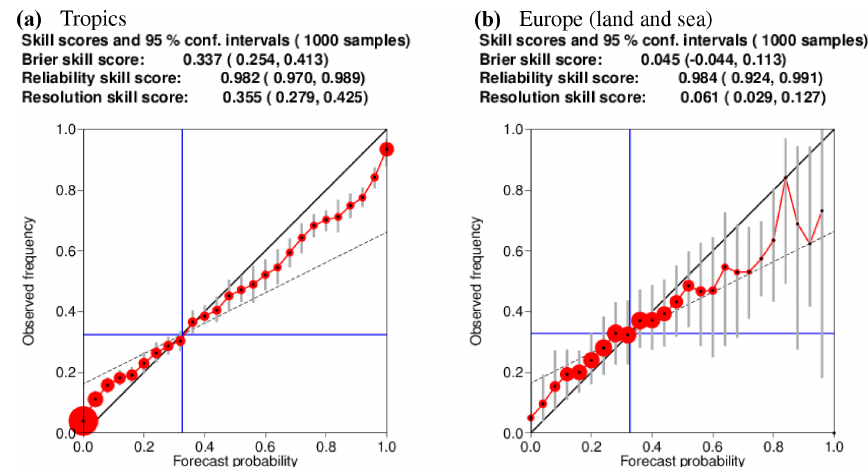
Figure 23. DJF 2m temperature reliability diagrams for SEAS5, computed including all grid points for the tropics ( a , 20 ◦ N to 20 ◦ S) and a European region ( b , 35 to 75 ◦ N, 12.5 ◦ W to 42.5 ◦ E) over the whole re-forecast period using 25 ensemble members. Verification data are ERA-Interim. Reliability diagrams are computed for 3-month average forecast anomalies in the upper third of the model climate distribution. Grey vertical lines indicate the 95% confidence